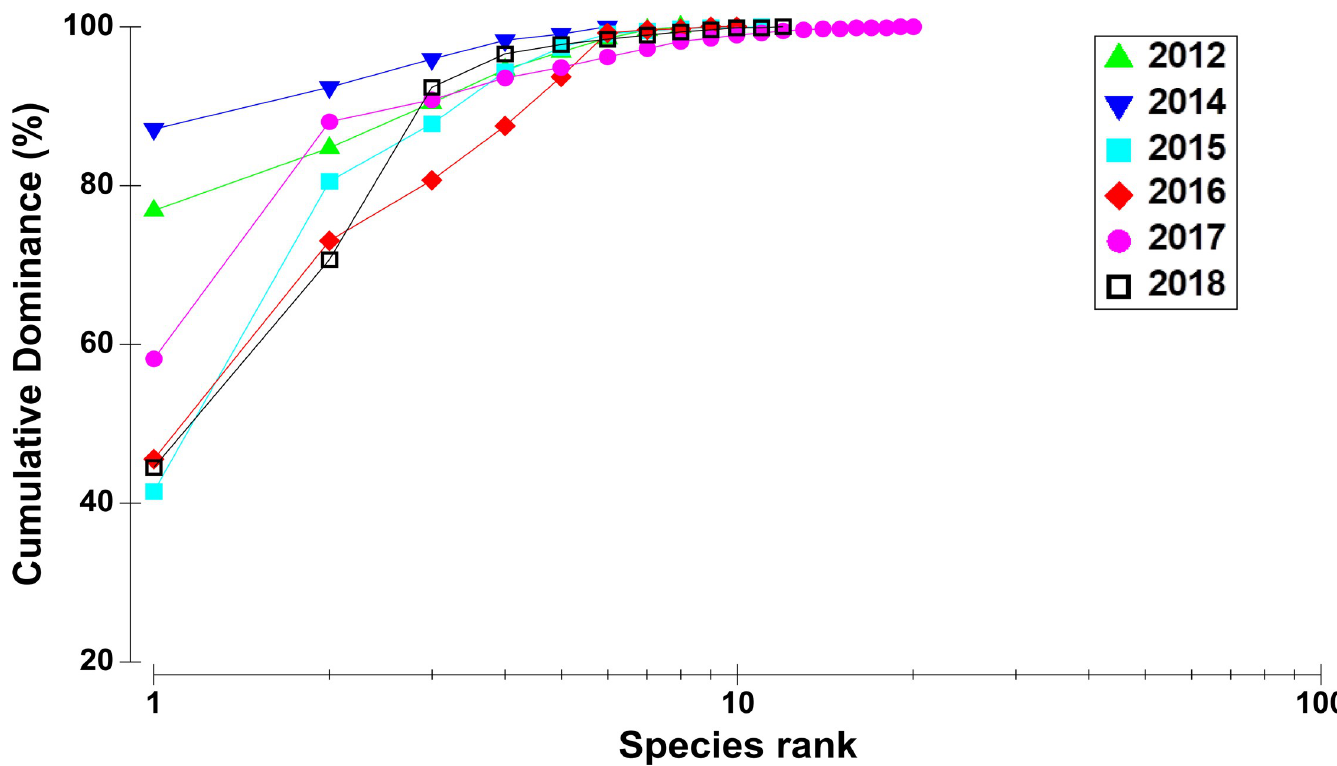
Fig 3. K -dominance curves for coverage of marine benthic organisms in each year at the study site in Terra Nova Bay, Antarctica.